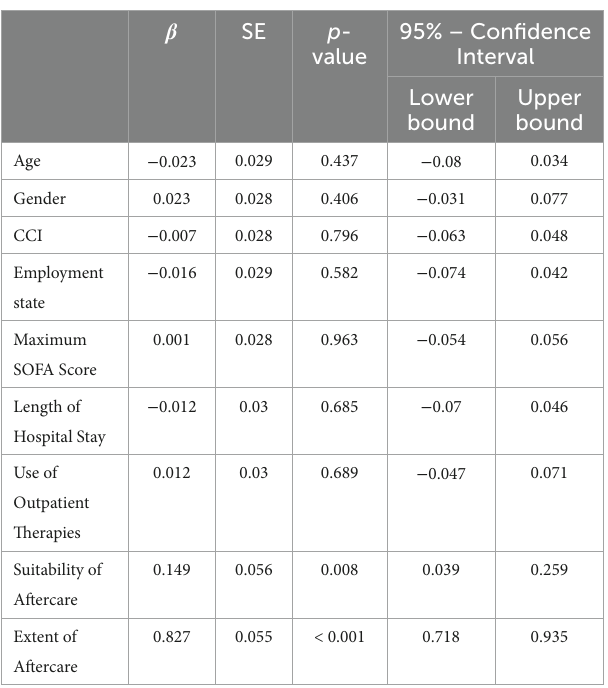
TABLE 3 Standardized regression coefficients, p -values and 95%-confidence intervals from the multiple linear regression analyses for the outcome satisfaction with aftercare at 12 months after ICU discharge ( n =